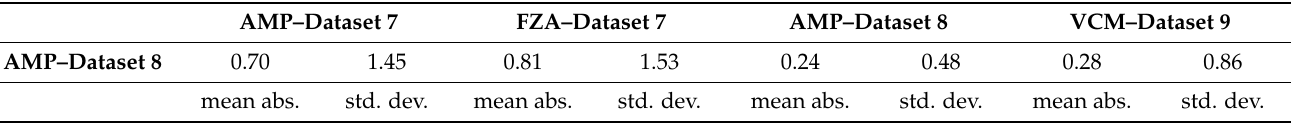
Table 14. Hausdorff distances between photogrammetric models for the small sculpture case study—datasets 7–9 (dis ‐ tances in mm).